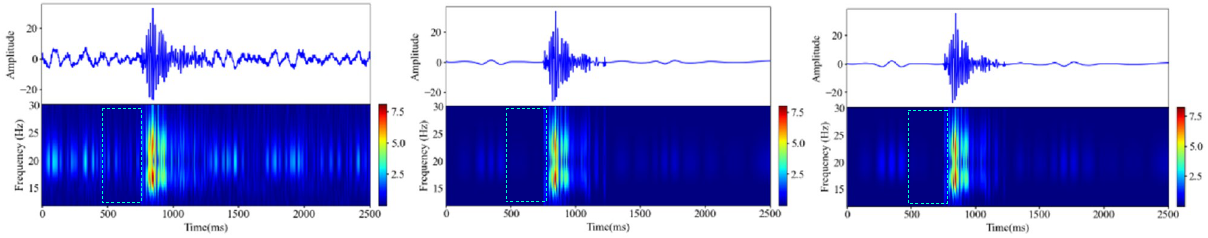
Figure 17. Denoising processing of rockburst monitoring signal (Spyder(Python3.6)). ( a ) Raw monitoring data ( b ) The method proposed in this paper ( c ) Huai-liang’s